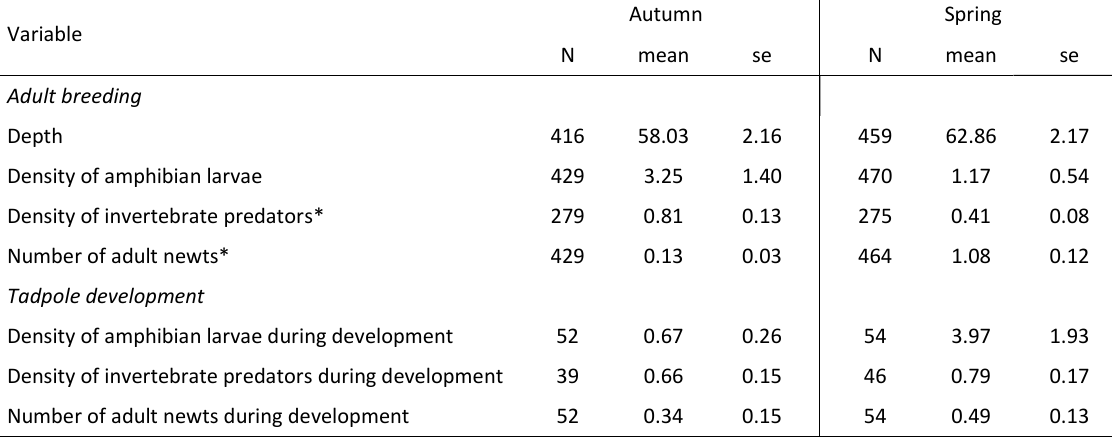
Table 1: Description of the seasonal niches regarding adult breeding (upper part) and larval development (lower part) of the Parsley Frog. Mean and standard error (se) of the explanatory variables depending on the season (autumn and spring). N: sample size. P.p is Pelodytes punctatus. Depth is in centimeters. Density of amphibian larvae or invertebrate predators is the mean number of individuals sampled in one dipnet sweep. Parsley Frog is excluded from calculations indicating “amphibian larvae” or “anuran adults”. * denotes significant difference between season for the considered variable.